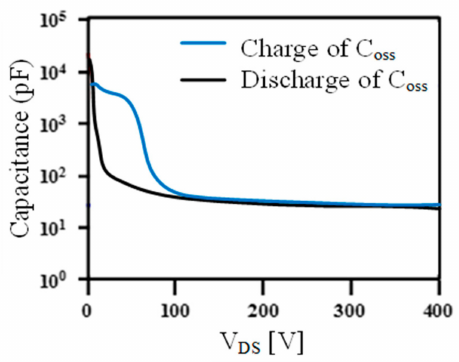
Figure 4. C OSS large-signal curves of device under test 1 (DUT1) (Table 1) during its charge and discharge obtained using (1) and the Auriga pulsed I–V